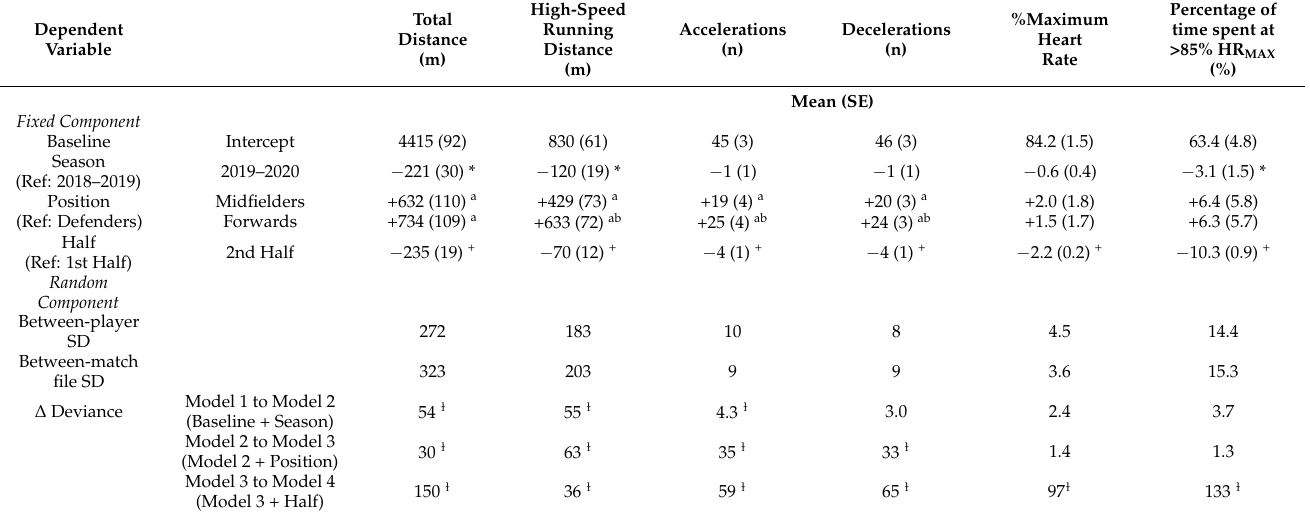
Table 3. Multilevel models examining the effects of season, position and half on normalised Global Positioning System (GPS) and heart rate variables (model 4), using 1st and 2nd half data, from matches where the playing format was 2